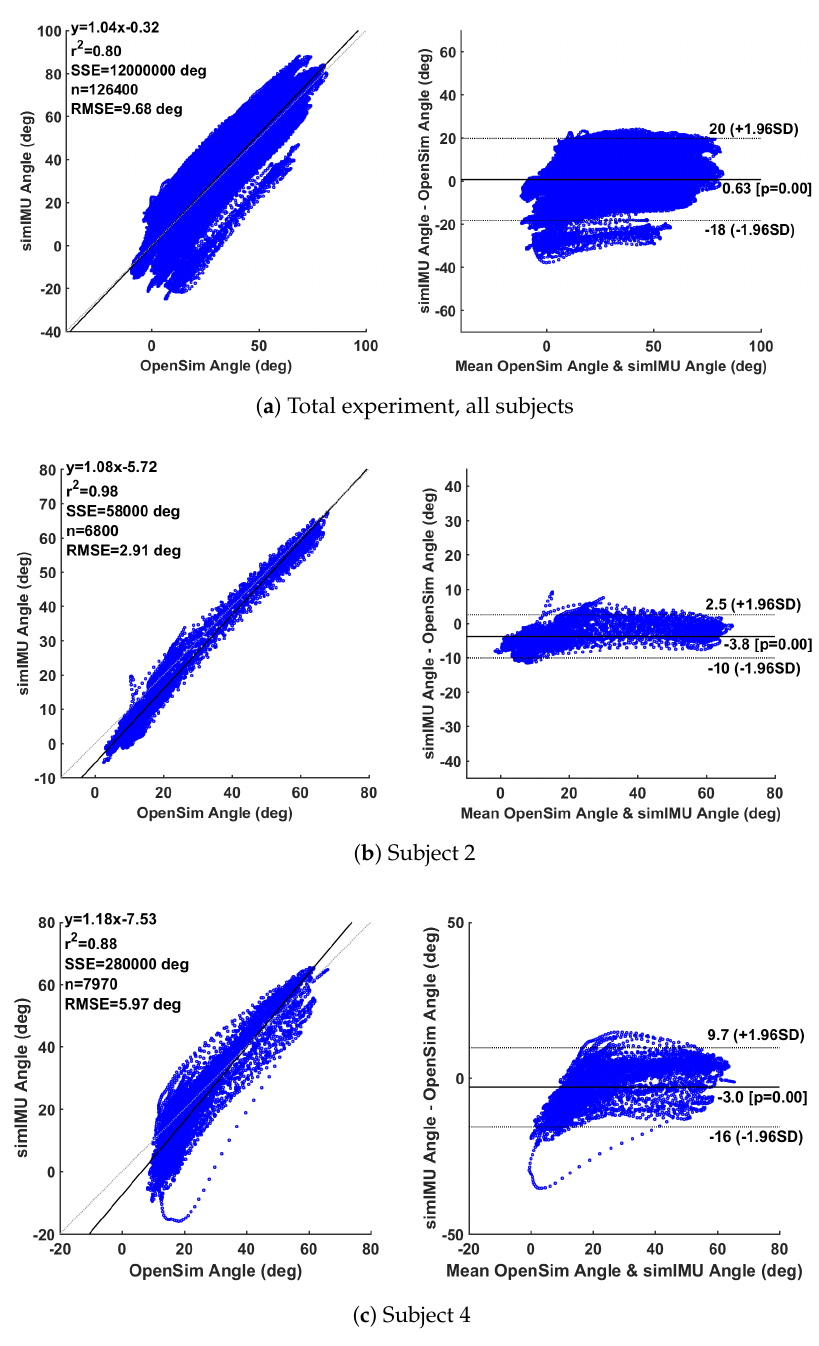
Figure 5. Selected Bland–Altman analyses; linear model given by y ( x ) with associated squared correlation coefficient r 2 , including sum of squared error (SSE) over n data points. Estimated data is the knee angle according to the proposed method on the simulated IMU